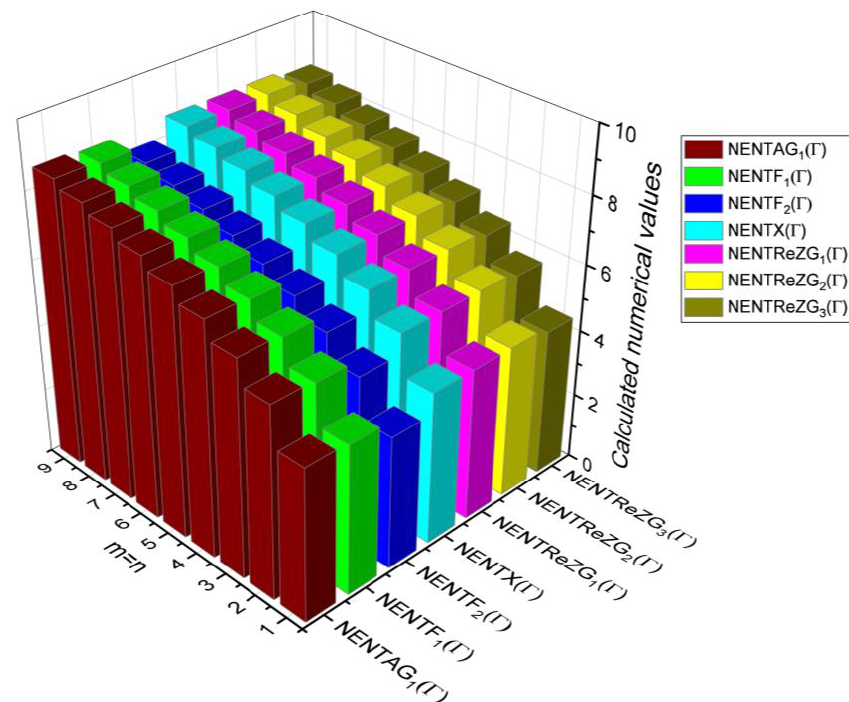
Figure 18. 3D plots for Table 16. Table 15. Comparison Table for Theorem 9.